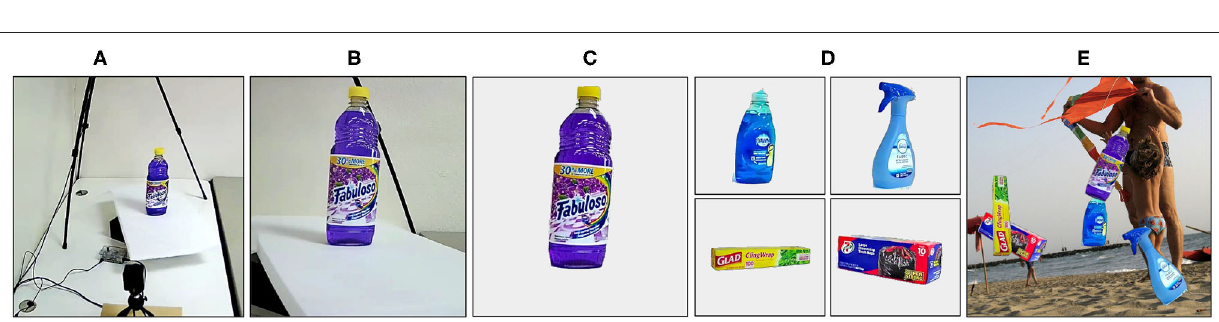
FIGURE 6 | Dominant Color Descriptor distribution of each product trained in our model. Each dot represents a centroid of a cluster of dominant color descriptors obtained for different angles of each product. Statistical Neighboring Embedding was used to visualize the similarity between different products. Dots that are closer to each other represent products that are similar in dominant color. E.g., “Palmolive Ultra strength” and “7 Select Dish Liquid” seen on the right.